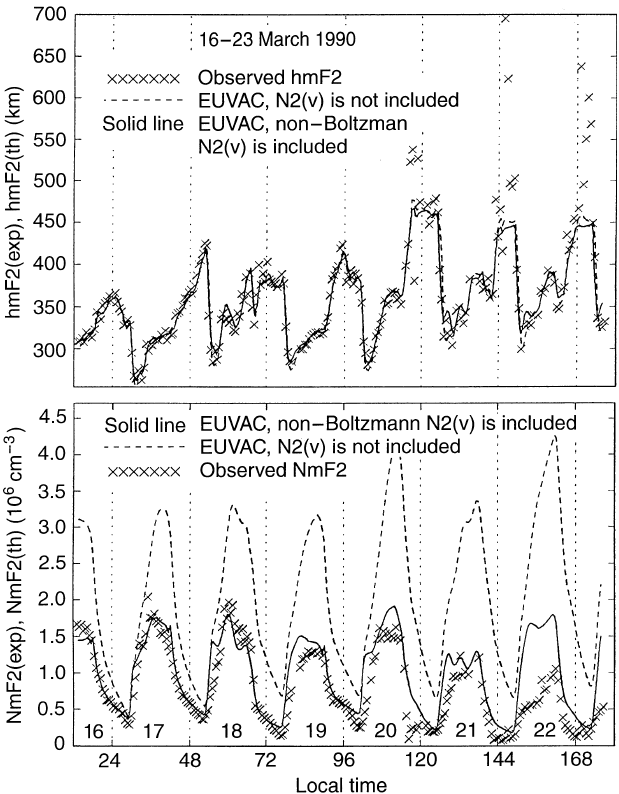
Fig. 1. Observed ( crosses ) and calculated F2 peak parameters above Millstone Hill for 16–23 March 1990. (Top) hmF2. (Bottom) NMF2. The solid lines are hmF2 and NmF2 from the IZMIRAN model when the non-Boltzmann populations of the first five vibrational levels of N 2 ( v ) are included in the calculated O (cid:135) (cid:133) 4 S (cid:134) recombination rate, and this recombination rate was decreased by the factor 1.5 during the nighttime periods of 16–18 and 19–20 March with solar zenith angles more than 90 (cid:14) , and dashed lines are hmF2 and NmF2 when N 2 ( v ) is not included in the calculations with the original O + ( 4 S) recomibination rate. The EUVAC solar flux model, the method of Eqs. A.18, A.20 for obtaining equivalent neutral winds from the height of the F2 peak electron density, and the O (cid:135) (cid:255) O collision frequency given by Salah (1993) were used in the IZMIRAN